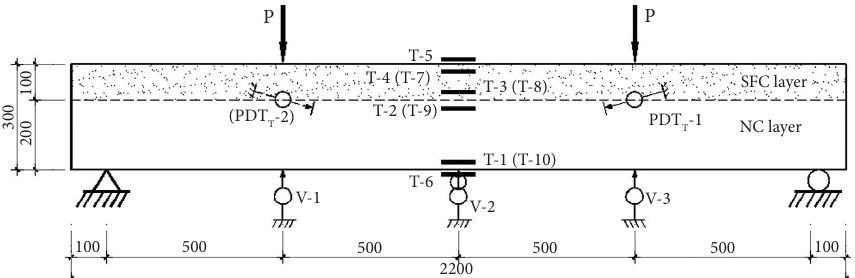
Figure 2: Double-layer beam measuring devices.